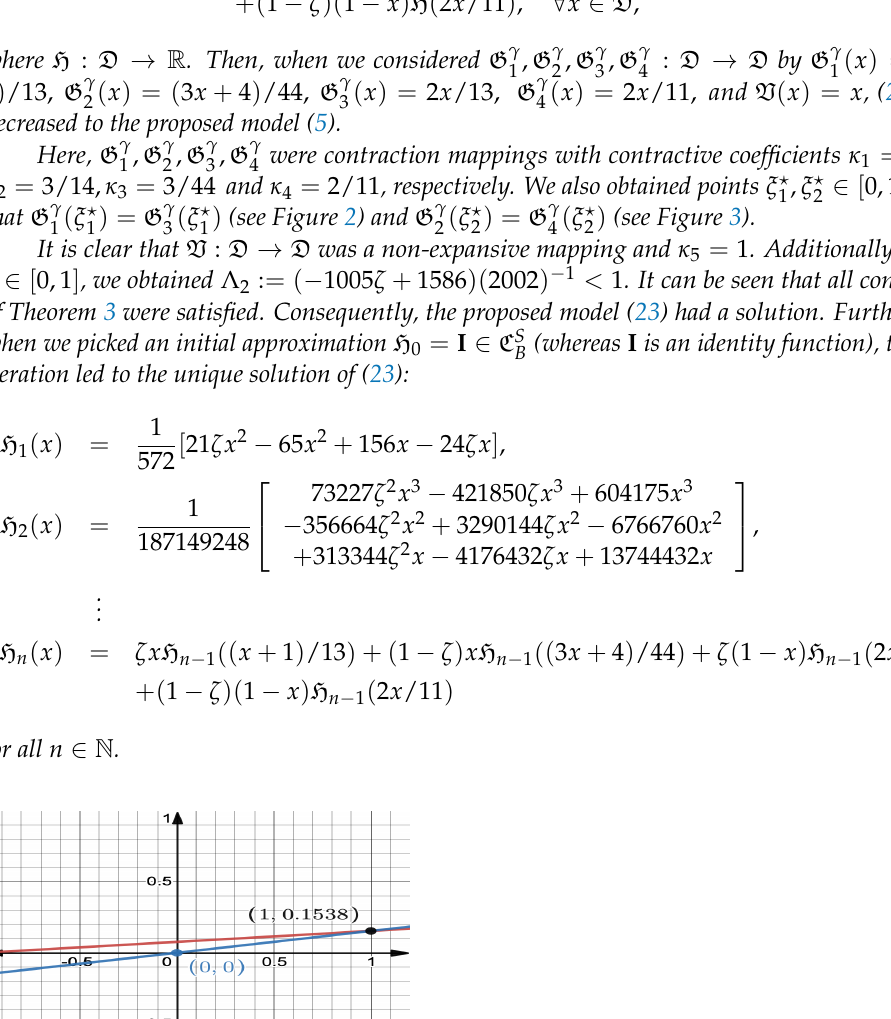
Figure 3. The graph of G γ